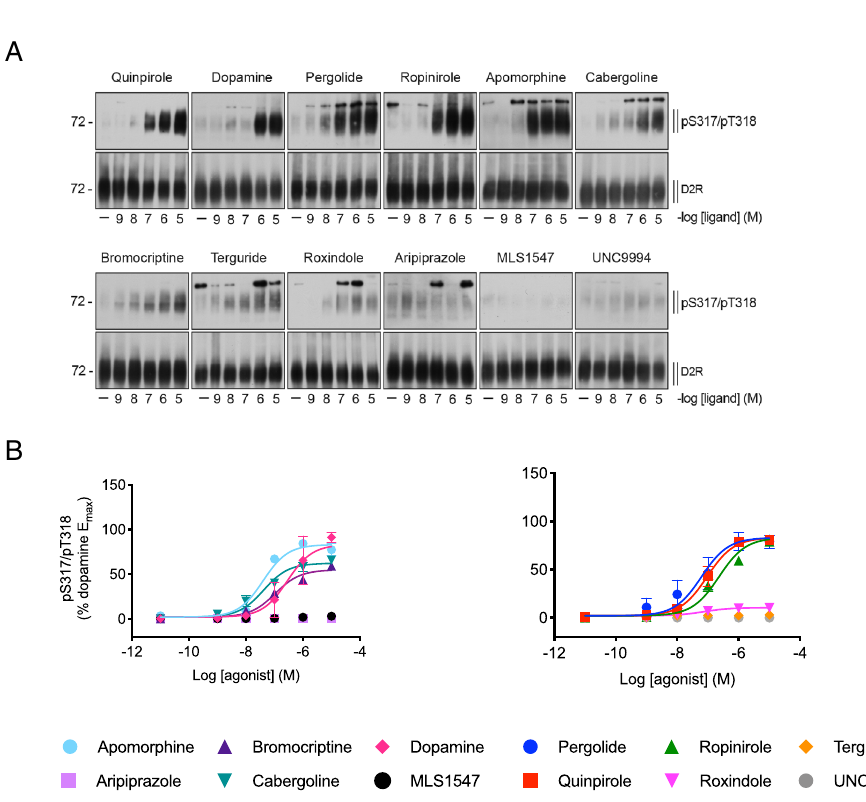
Figure 4. Concentration-dependent agonist-induced Ser 317 /Thr 318 phosphorylation. ( A ) HA-hD 2 R expressing HEK293 cells were either stimulated with vehicle (solvent) or quinpirole, dopamine, pergolide, ropinirole, apomorphine, cabergoline, bromocriptine, terguride, roxindole, aripiprazole, MLS1547 or UNC9994 at concentrations ranging from 10 –9 to 10 –5 M for 10 min at 37 °C. Lysates were immunoblotted with antibody to pSer 317 /Thr 318 [5102]. Blots were stripped and reprobed for D 2 R [5106] to confirm equal loading of the gel. Blots are representative, n = 3. ( B ) Densitometry analysis of Western blots. pSer 317 /pThr 318 signals were normalized to the total D 2 R signal and expressed as a percentage of the signal detected when cells were stimulated with 10 μM dopamine (Fig. 4). These data are fitted to a three parameter concentration response curve (Eq.